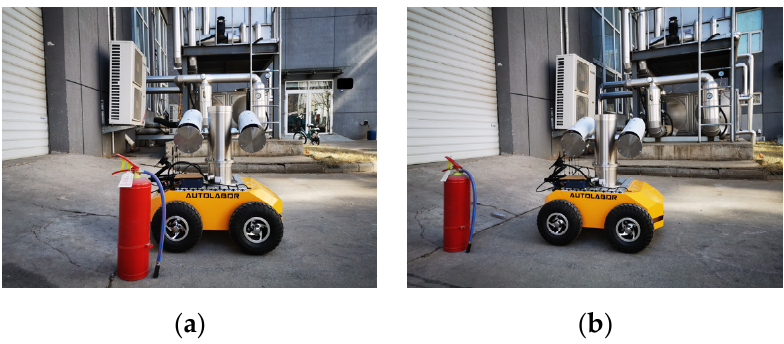
Figure 19. Robot pose adjustment experiment; ( a ) position A; ( b ) position B.